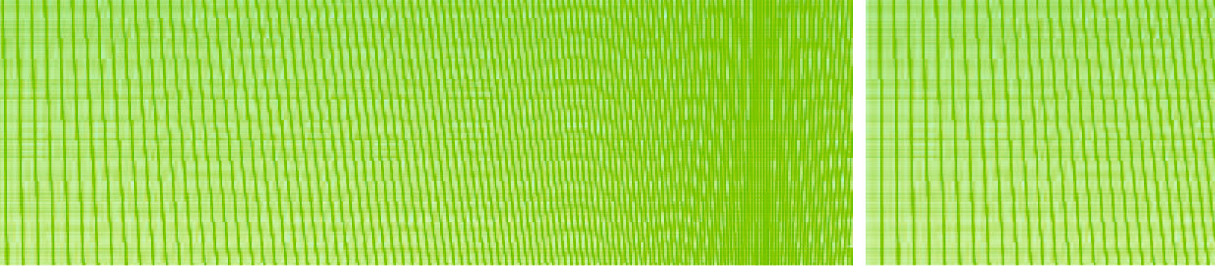
Figure 2: Overall grid division and its local